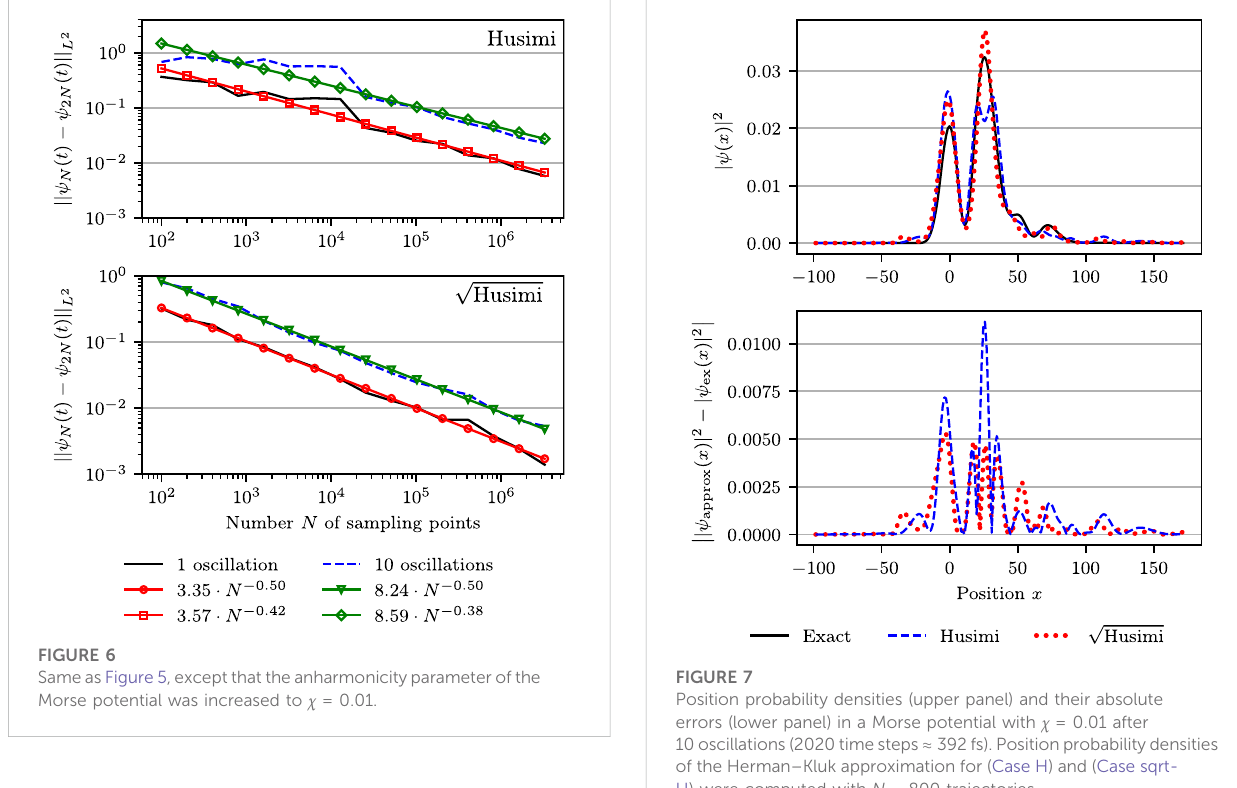
probability densities of the “ exact ” quantum grid-based solution with those of (Case H) and (Case sqrt-H). Both fi gures were obtained in a Morsepotentialwithanharmonicityparameter χ =0.01atatimeafterten oscillations.Thedifferenceliesinthenumberoftrajectoriesused.Theless